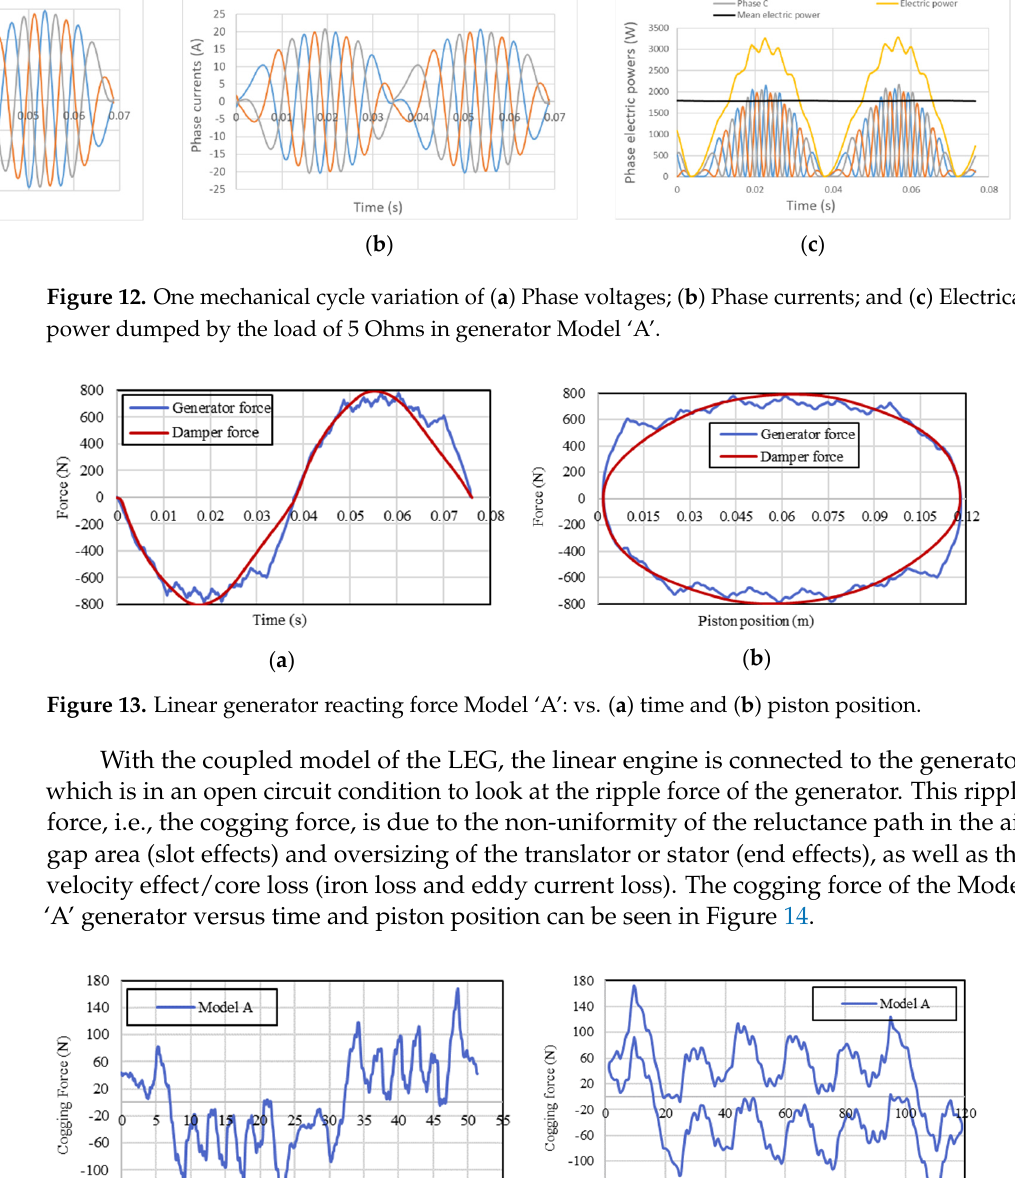
Figure 14. Cogging force of Model ‘A’ generator versus: ( a ) time and ( b ) piston position. Figure 13. Linear generator reacting force Model ‘A’: vs. ( a ) time and ( b ) piston position.